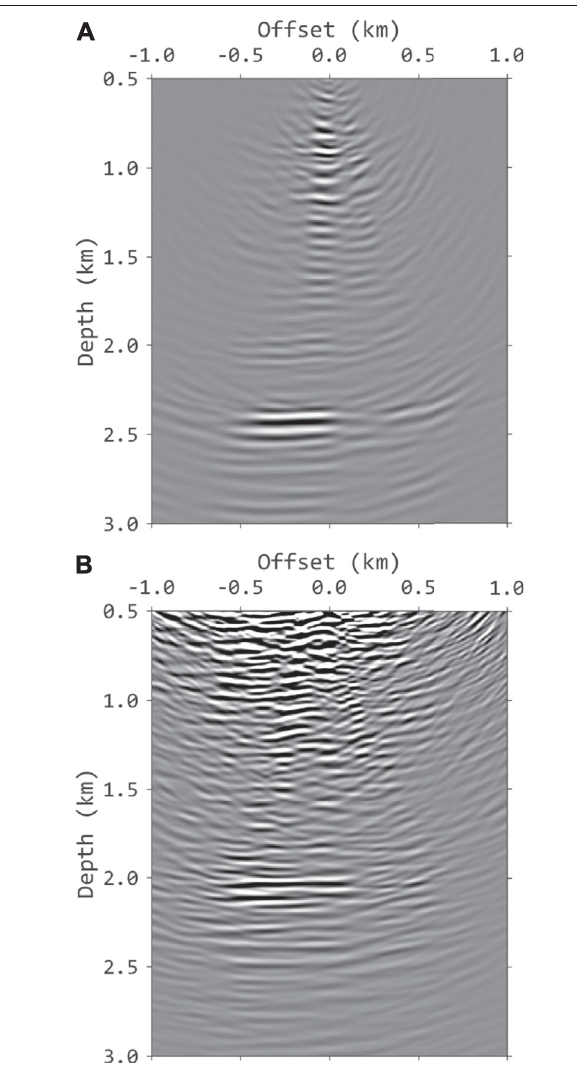
FIGURE 12 | The joint migration images using primaries and multiples. (A) The result using cross-correlation imaging condition with wave fi eld decomposition, (B) the result using inverse-scattering imaging condition with wave fi eld decomposition. (B) provides the best result in resolution and frequency